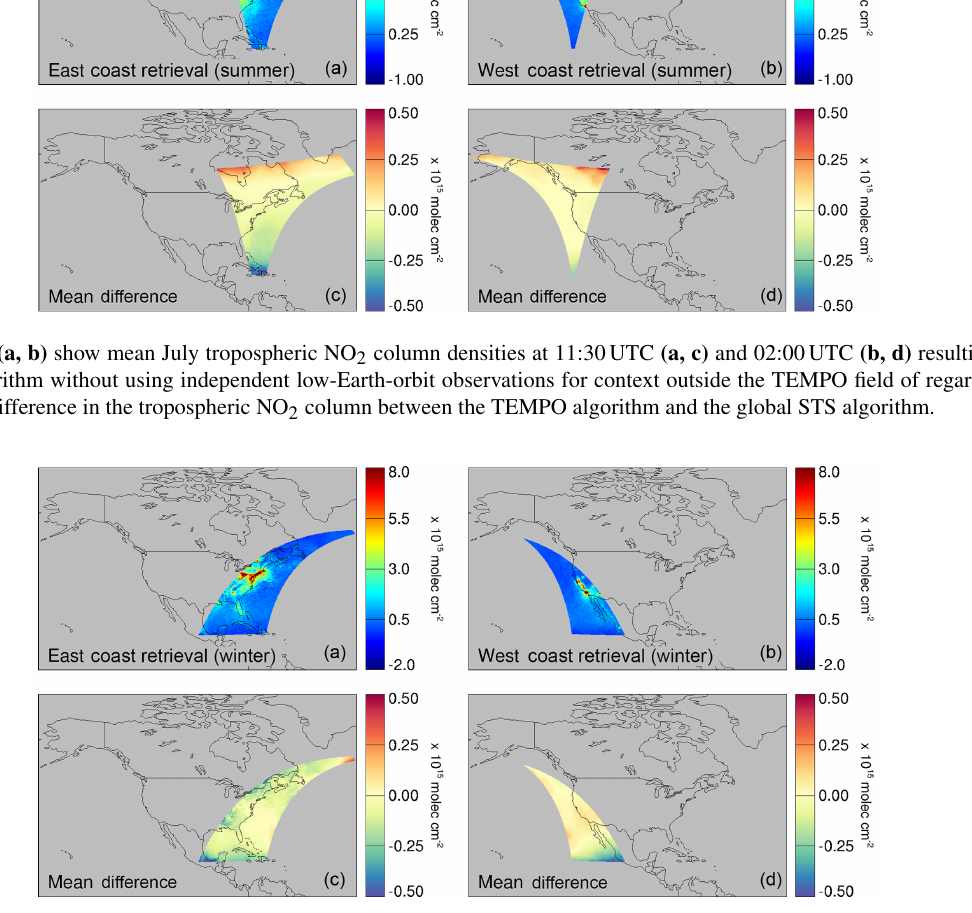
Figure 13. Panels (a, b) show mean January tropospheric NO 2 column densities at 14:00UTC (a, c) and 23:30UTC (b, d) resulting from our TEMPO STS algorithm without using independent low-Earth-orbit observations for context outside the TEMPO field of regard. (c, d) show absolute difference in the tropospheric NO 2 column between the TEMPO algorithm and the global